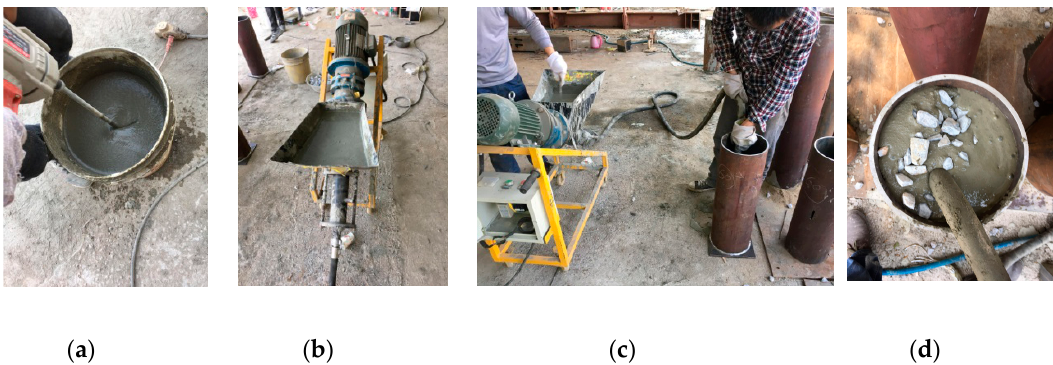
Figure 2. Preparation process of preplaced aggregate concrete-filled steel tube (CFT-PAC) specimens. ( a ) Preparation of grouting mortar; ( b ) Grouting device; ( c ) Grouting process; ( d ) Grouting effect.